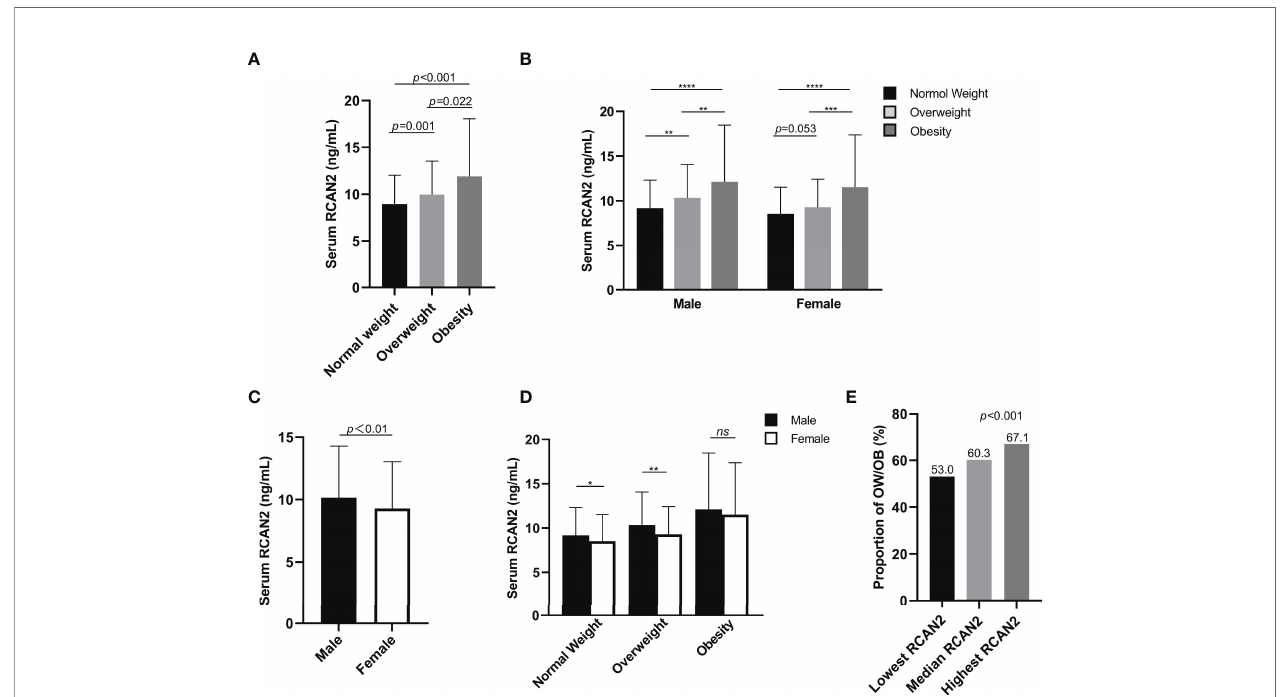
FIGURE 1 | Serum RCAN2 concentrations in subjects with normal weight, overweight and obesity (A) . Serum RCAN2 concentrations in males and females with normal weight, overweight and obesity (B) . Comparison of the overall level of RCAN2 between men and women (C) . Comparison of RCAN2 concentrations in men and women across BMI categories (D) . Proportion of overweight or obesity in different concentrations of serum RCAN2 (E) . p values were derived from Mann – Whitney U test for serum RCAN2 concentrations, and chi-square test for the categorical variables. * p < 0.05, ** p < 0.01, *** p < 0.001, **** p < 0.0001, ns p >